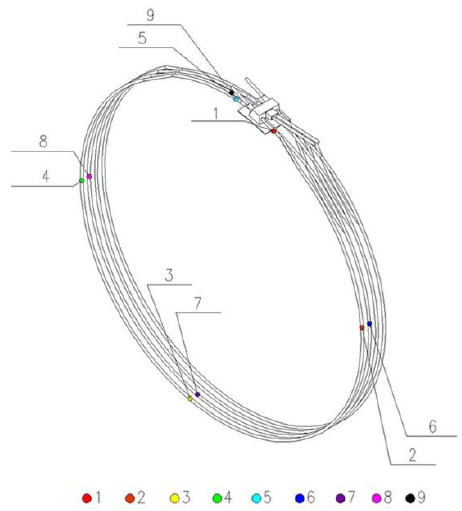
Figure 12. Arrangement of the measuring points for each strand wire.